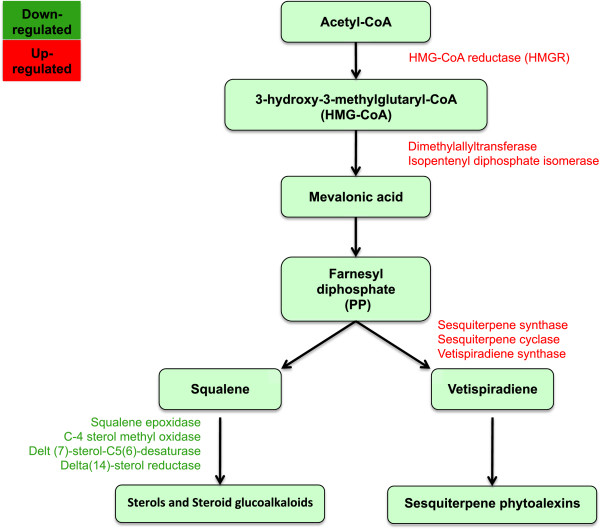
BABA-influenced changes within the mevalonate pathway. The effect of 10 mM BABA on transcripts encoding genes within the mevalonate pathway in leaves of potato. BABA caused a down-regulation of several transcripts involved with sterol biosynthesis, whereas transcripts involved with sesquiterpene phytoalexin biosynthesis were up-regulated. Transcripts with significantly changed expression (adj. p-value <0.05) are denoted in red (up-regulation) and green (down-regulation).